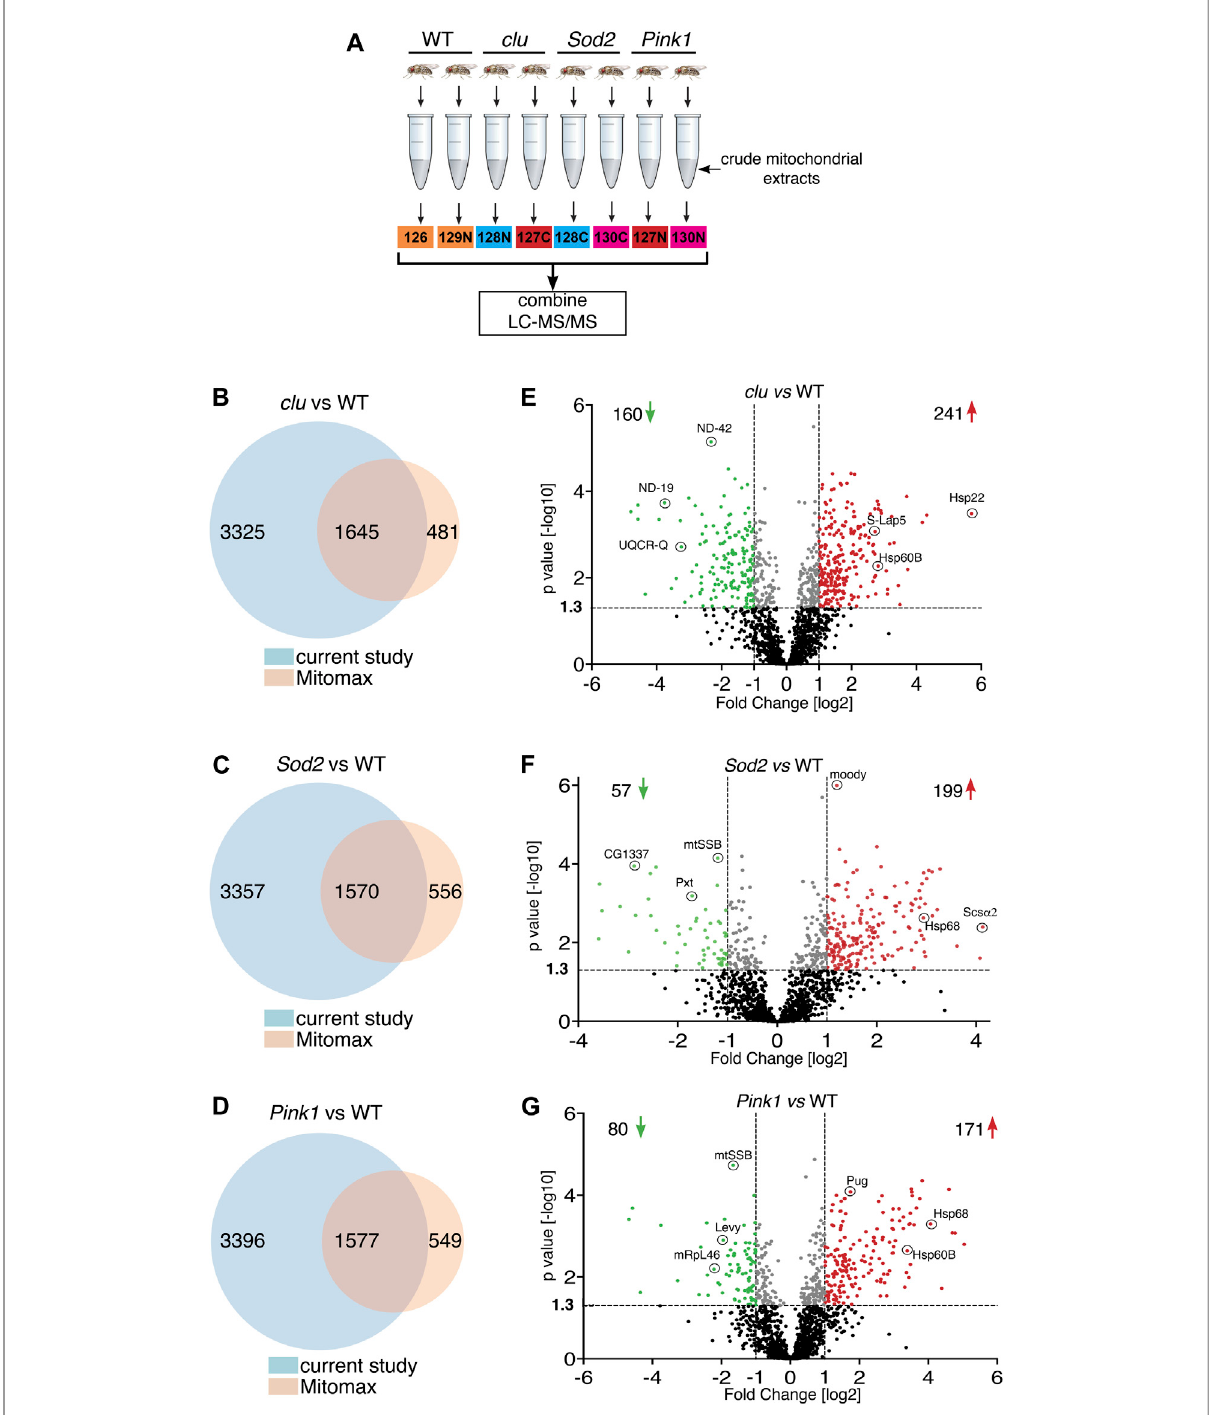
Mitochondrial protein abundance in clu, Sod2 and Pink1 mutants. (A) Schematic of the TMT mass spectrometry method for analyzing mitochondrial extract from wild type (WT), clu , Sod2 , and Pink1 mutant adults. (B – D) Venn diagrams comparing the number of proteins identi fi ed in clu (B) , Sod2 (C) and Pink1 (D) mutantsvs.proteinslistedintheMitomaxdatabase. (E – G) Volcanoplotsshowingtheproteins identi fi edbyLC-MS/MS analysis.Proteinsfrom clu (E) , Sod2 (F) and Pink1 (G) mutantswerecomparedwithWT. p values(-log10)andFoldChange(log2)wereplottedon the y -axis and x -axis, respectively. The vertical dotted lines mark the cut-off limits for Fold Change [log2] > 1 and the horizontal dotted line denotes the p value[ − log10]=1.3.Proteinsthatweresigni fi cantlylessabundant(i.e.,FoldChange[log2] < 1and p value[log10] > 1.3)areshowningreendots, whereas proteins that were signi fi cantly more abundant (i.e., Fold Change [log2] > 1 and p value [ − log10] > 1.3) are shown in red dots. A few